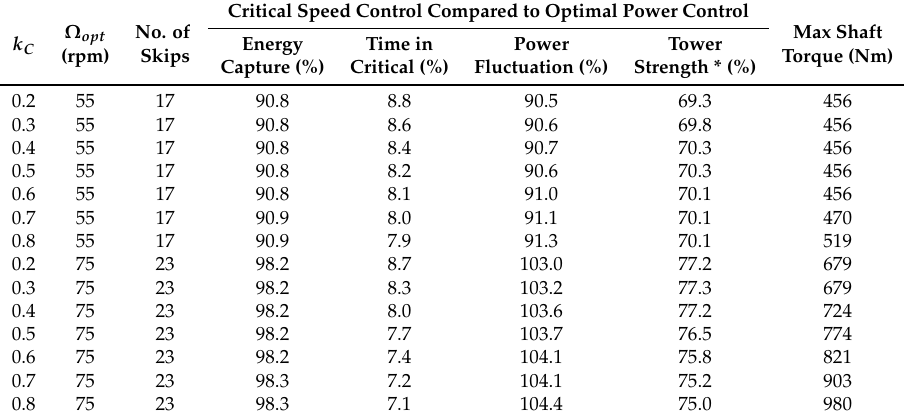
Table 5. Simulation results of the critical speed controller with a parameter sweep of k C . In each case, the performance is compared to an optimal torque simulation without a critical